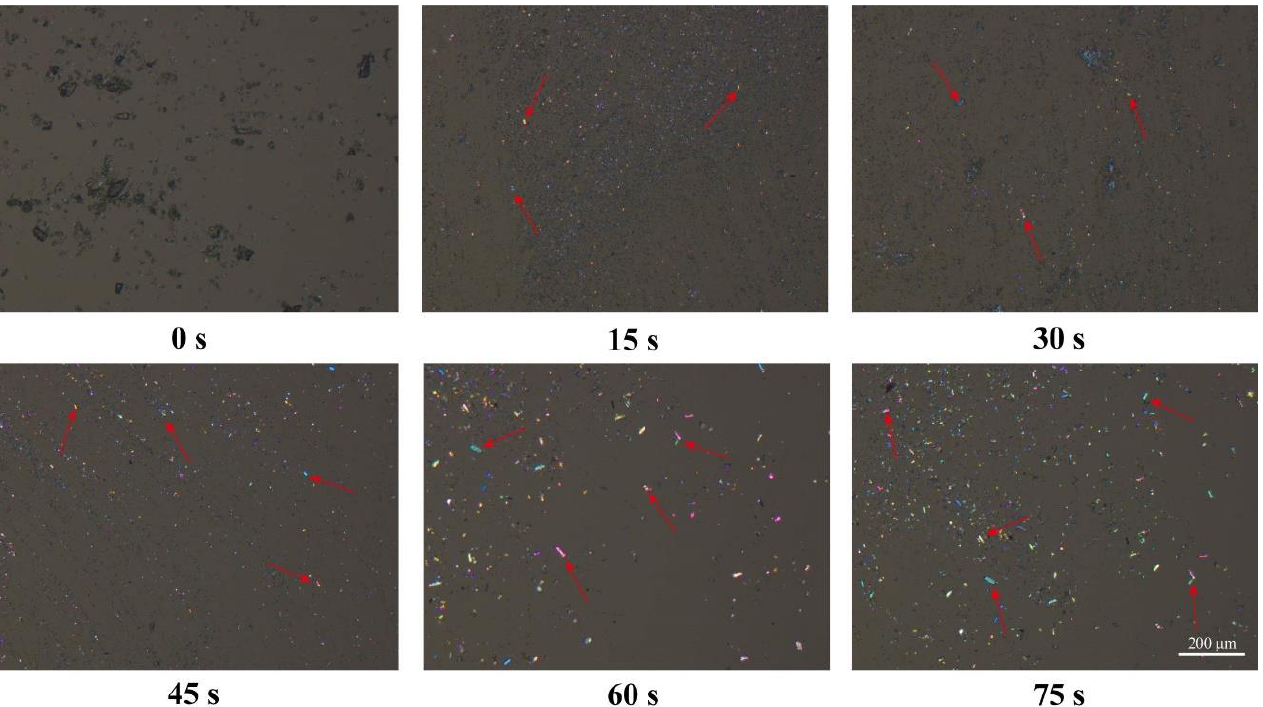
Figure 2. PLM images of amorphous ACM in water at different points (red arrows indicate birefringence).